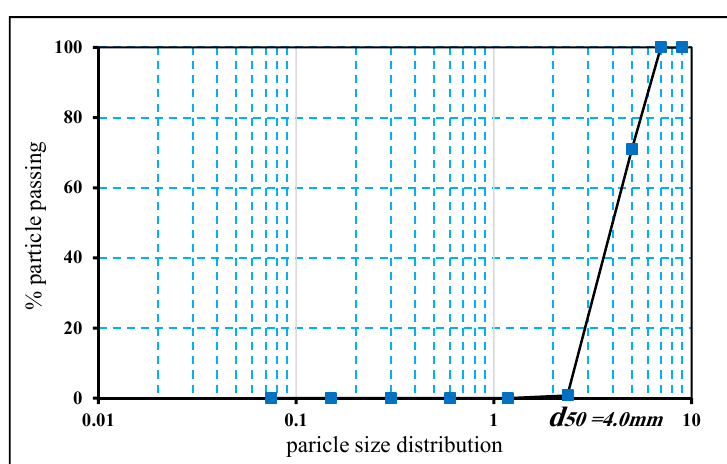
Figure 2. The experimental flume.